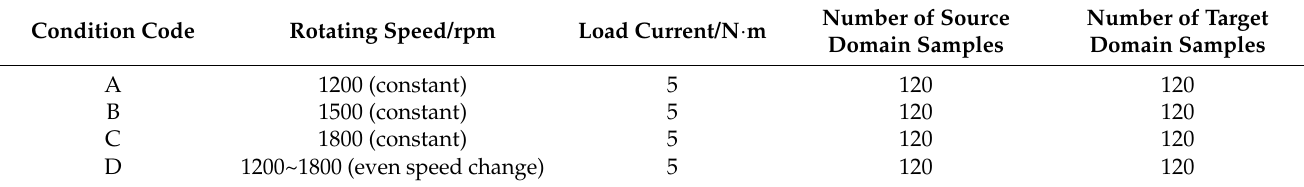
Table 5. Design of the experimental conditions.